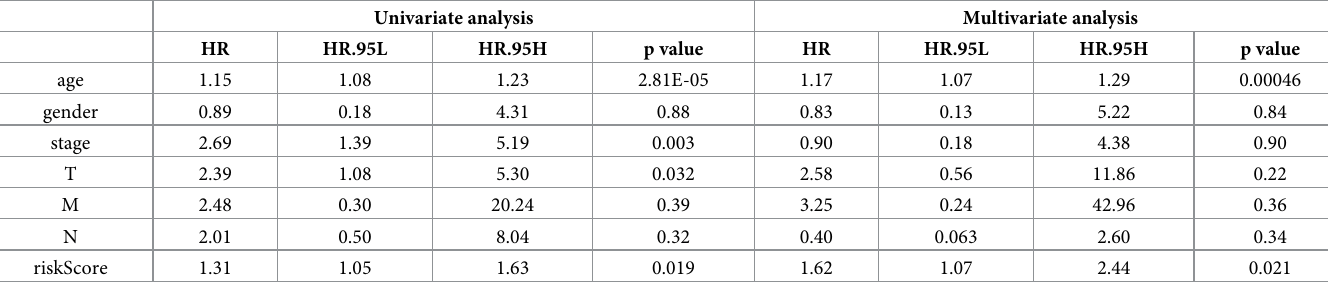
Table 2. The prognostic effect of different clinical parameters.